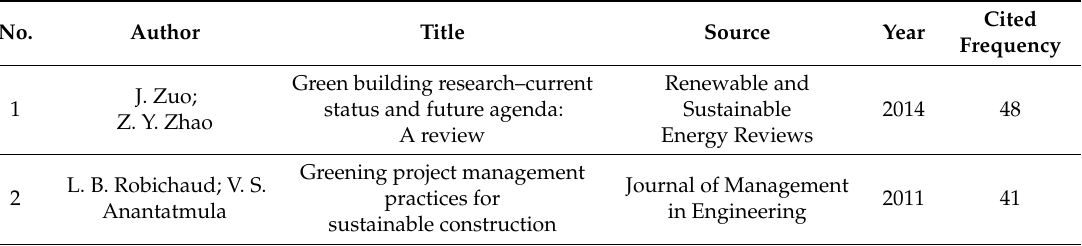
Table 1. Top ten critical GBE publications.